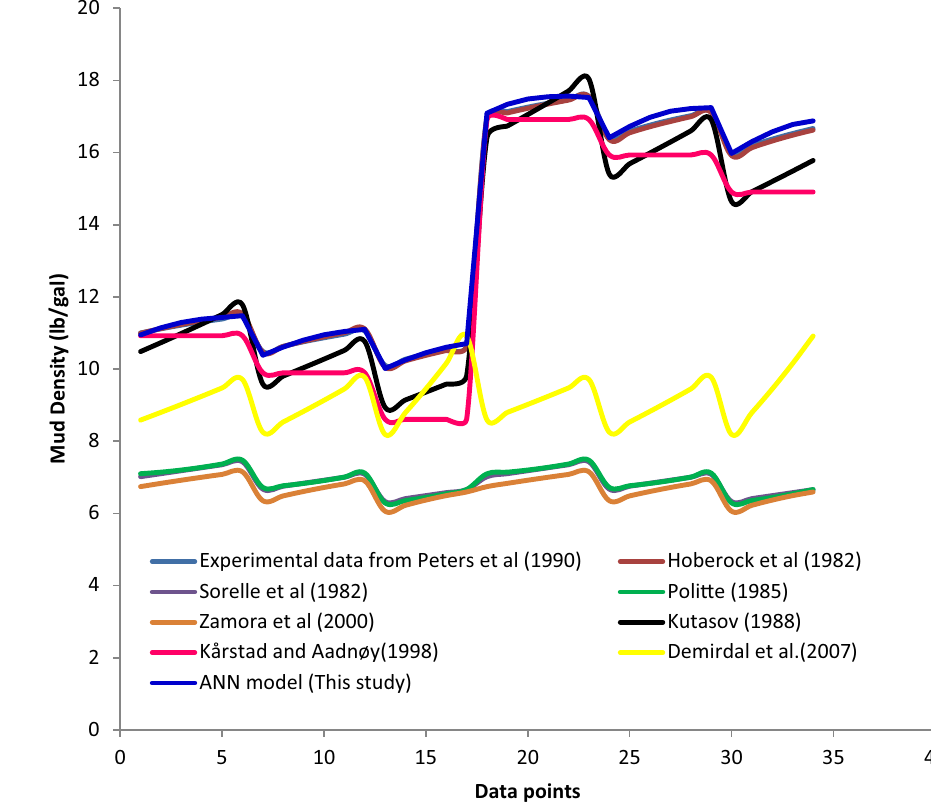
Fig. 5 Performance of various models to unfamiliar